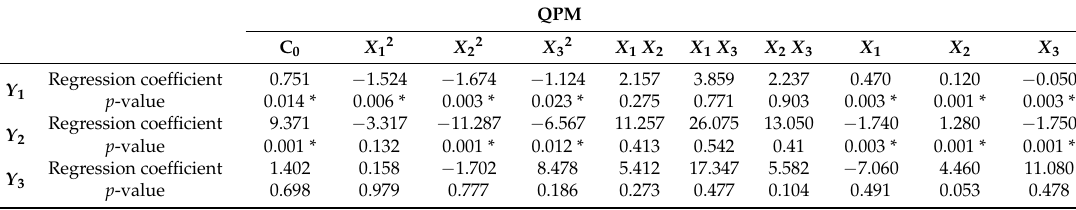
Table 3. Coefficients of the constructed QPM